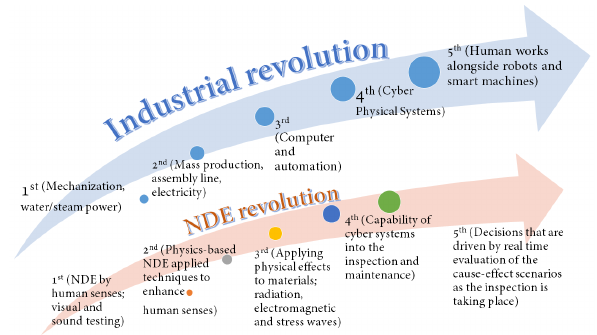
Figure 10. Similarities between industrial and NDE revolution